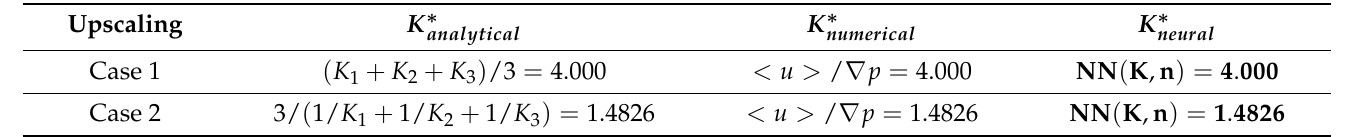
Table 1. A comparison of the upscaled permeability values obtained using analytical, numerical and neural upscaling methods. The results are in close agreement for both the test